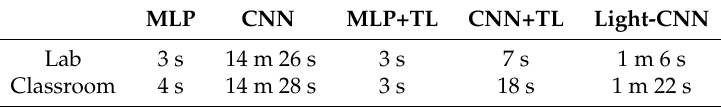
Figure 7. UWB channel classification accuracy of the light CNN and CNN with TL in different places. Table 6. Training time comparison of different neural